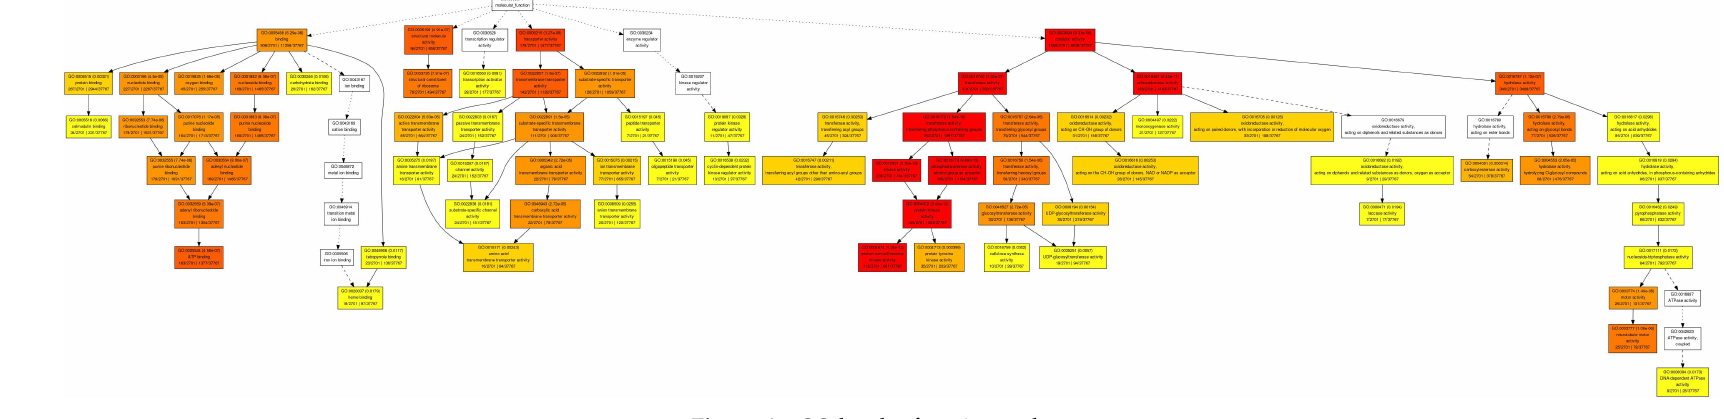
Figure A3. Molecular function